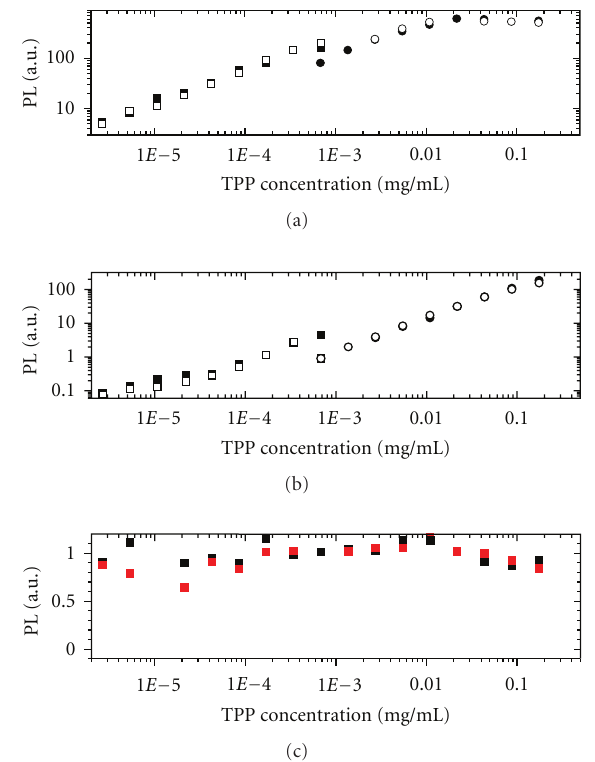
Figure 3: PL emission of TPP and its 10:1 SWNT composite upon photoexcitation in the Soret band region at 417 nm (a) and the Q band region at 590nm (b) as a function of concentration for high concentration solutions. Also shown is the ratio of composite to porphyrin emission as a function of concentration upon excitation at both wavelengths. The 2-mm cuvette was used for all solutions at concentrations higher than 0.001